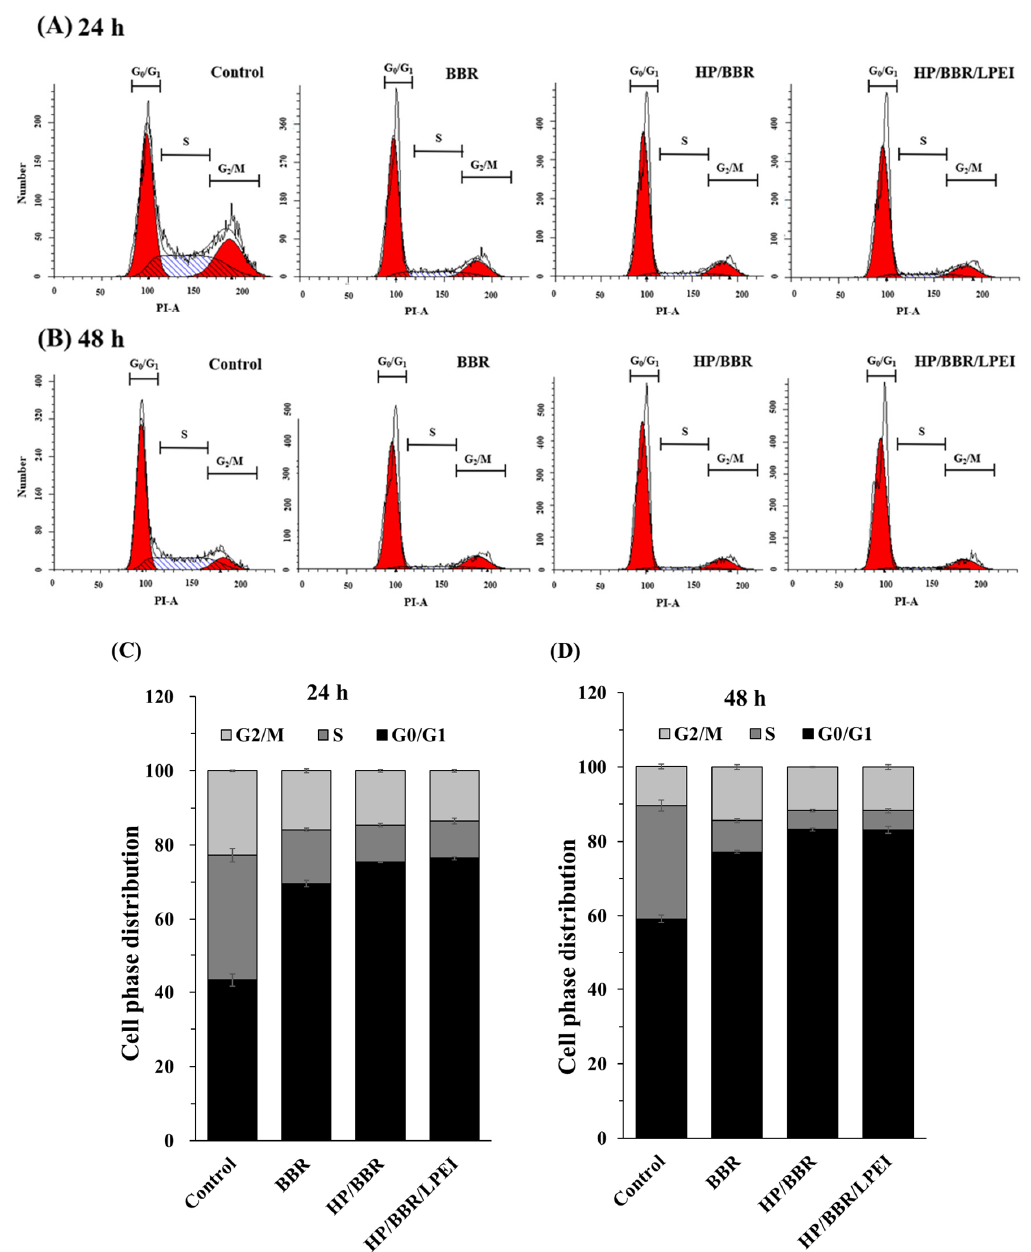
Figure 5. The effects of BBR and BBR NPs (HP/BBR and HP/BBR/LPEI NPs) on cell cycle distribution in U-2 OS cells. U-2 OS cells were treated with BBR, HP/BBR NPs, or HP/BBR/LPEI NPs containing 50 μM BBR for 24 or 48 h and were harvested for cell cycle distribution assay by flow cytometry assay. The results of the flow cytometry assays after 24 h ( A ) and 48 h ( B ) are presented, and the cell cycle distributions in percentages after 24 h ( C ) and 48 h ( D ) of treatment are presented. Experiments were performed in triplicate as described in Materials and